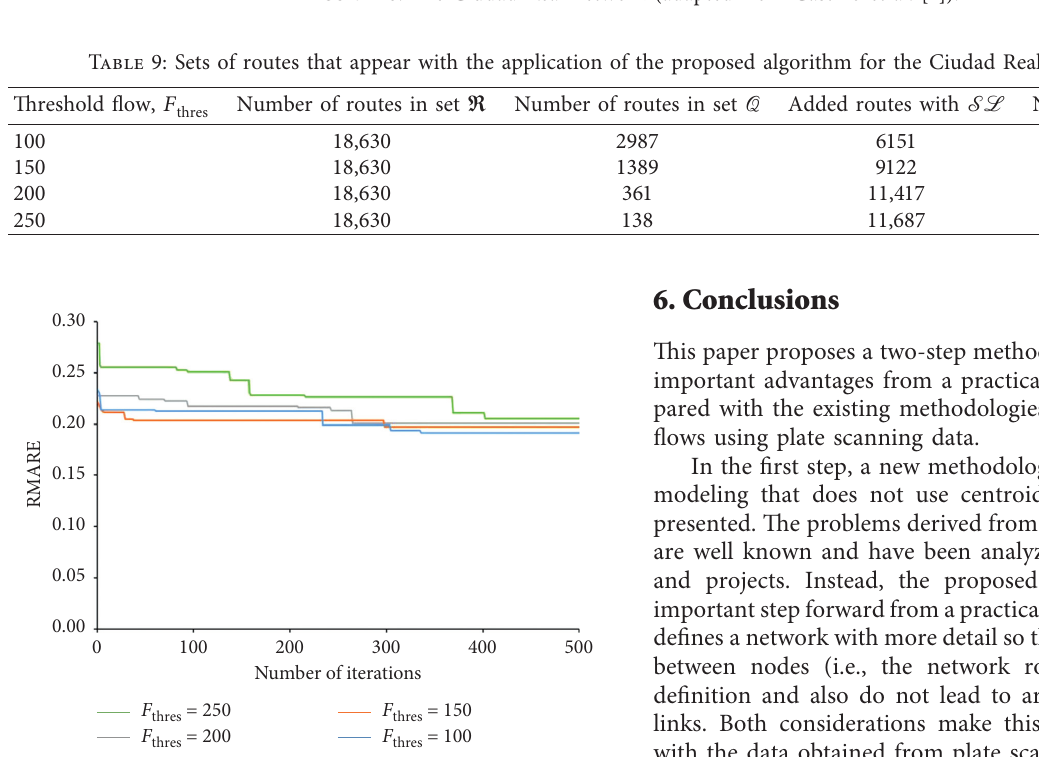
Figure 11: Evolution of RMARE best for the Ciudad Real